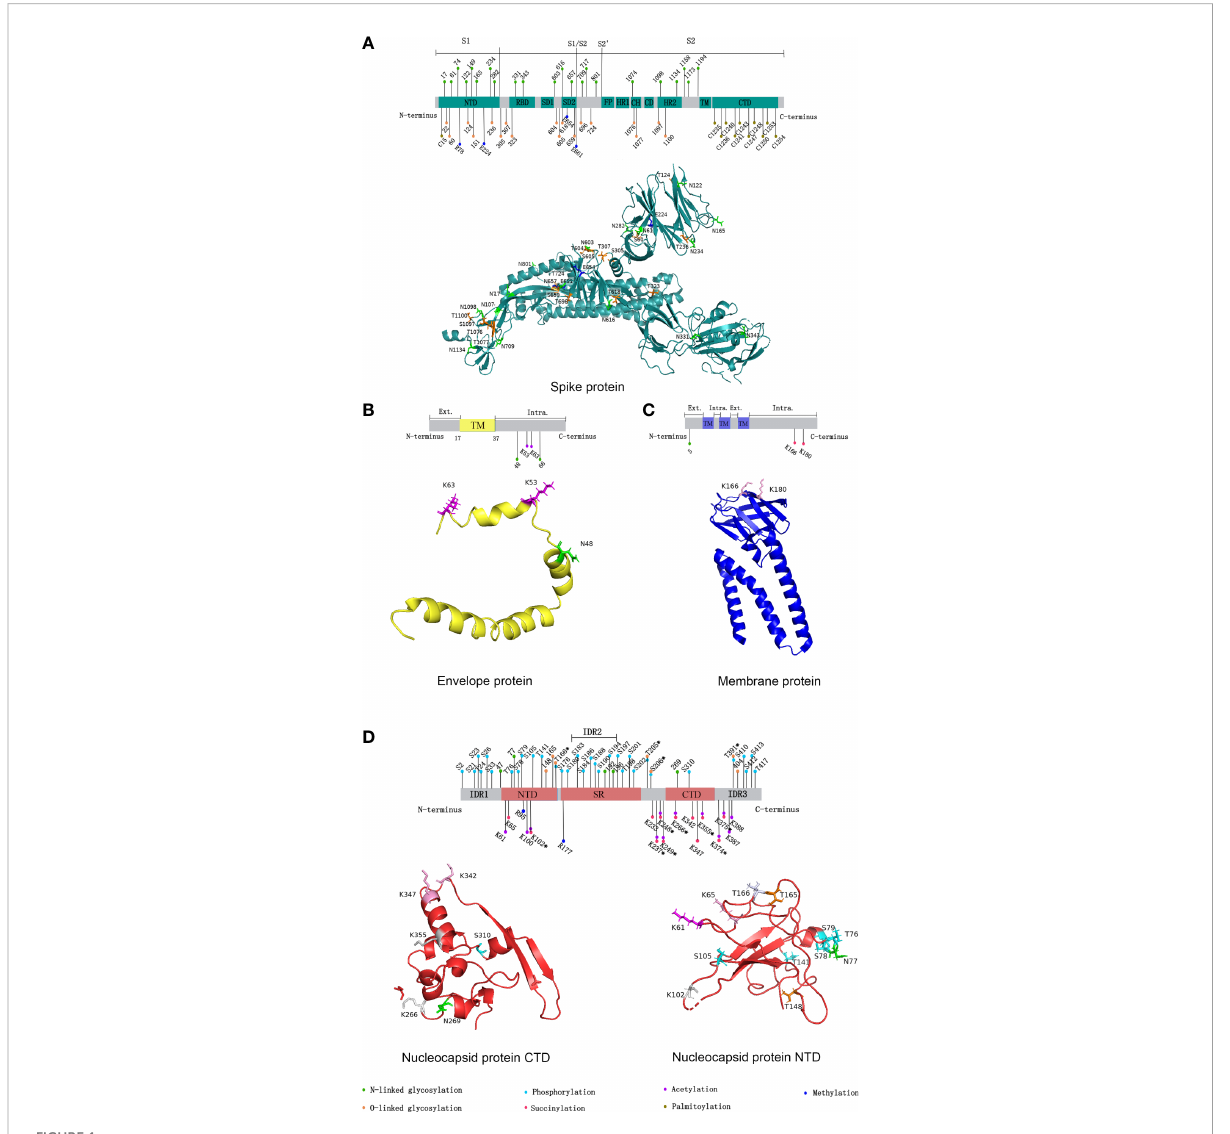
FIGURE 1 Distribution of SARS-CoV-2 structural proteins post-translational modi fi cation sites in 2D and 3D structural models. (A) Distribution of SARS- CoV-2 spike protein post-translational modi fi cation sites. (B) Distribution of SARS-CoV-2 envelope protein post-translational modi fi cation sites. (C) Distribution of SARS-CoV-2 membrane protein post-translational modi fi cation sites. (D) Distribution of SARS-CoV-2 nucleocapsid protein post-translational modi fi cation sites. In 2D structural models, the post-translational modi fi cations represented by the different colors are shown in the fi gure legends. NTD, N-terminal domain; CTD, C-terminal domain; RBD, receptor binding domain; SD1/2, subdomain 1/2; FP, fusion peptide; HR1/2, heptad repeat region 1/2; CH, central helix; CD, connector domain; TM, transmembrane region; Ext., external; Intra., intravirion. (Sites with * indicate that various protein post-translational modi fi cations have occurred.) In 3D structural models, different colors were used to represent different post-translational modi fi cations occurring at a certain site. Green: N-linked glycosylation; Orange: O-linked glycosylation; Cyan: phosphorylation; Magenta: succinylation; Pink: acetylation; Blue: methylation; Gray 90: succinylation and acetylation; Bluewhite: O-linked glycosylation and phosphorylation. Due to the limitations of the 3D model, some sites could not be marked. We used the open source software PyMOL for mapping, and data were obtained from the RCSB PDB database